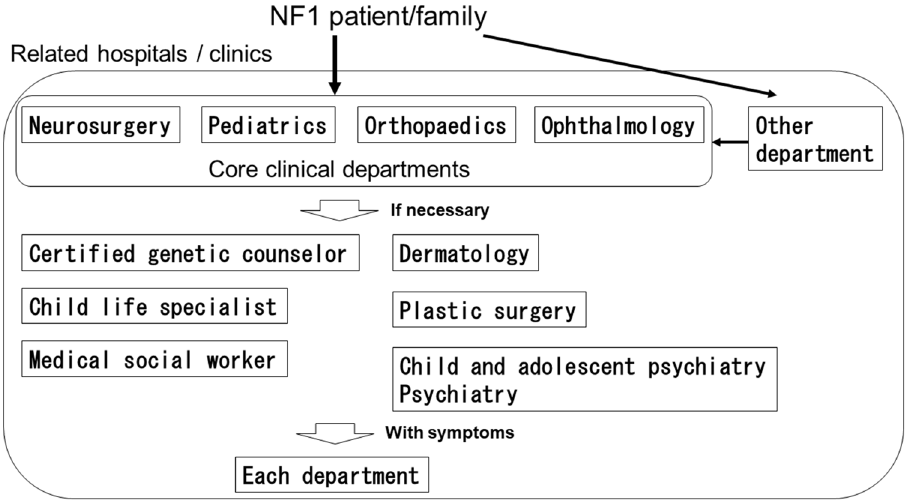
Figure 1. Medical treatment flow for NF1 patients under 15 years old in our